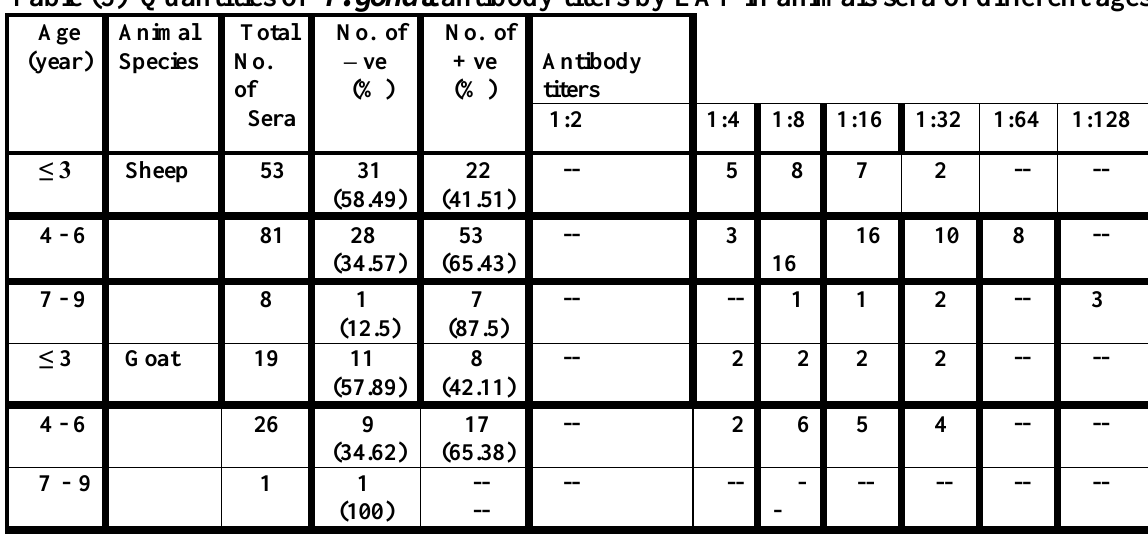
Table (5) Quantities of T. gondii antibody titers by LAT in animals sera of different